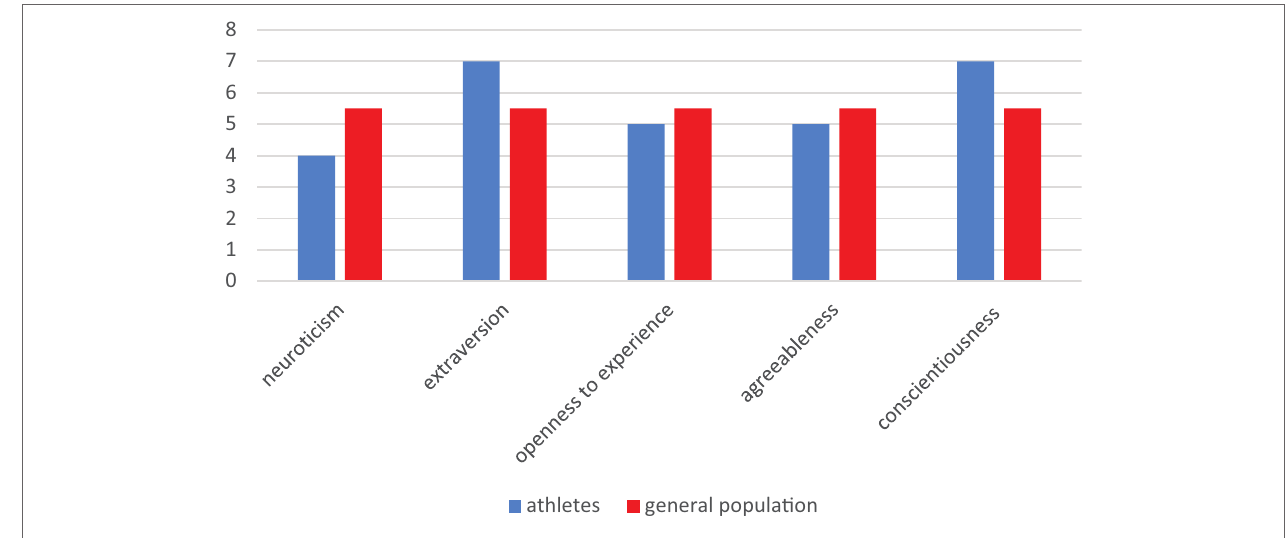
FIGURE 1 | A column chart of the sten scores for personality profile of all tested athletes and the general population.